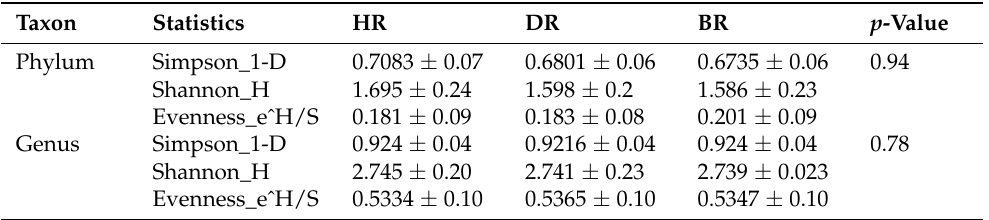
Table 1. Diversity and evenness of microbial communities present in the rhizosphere and bulk soil samples.